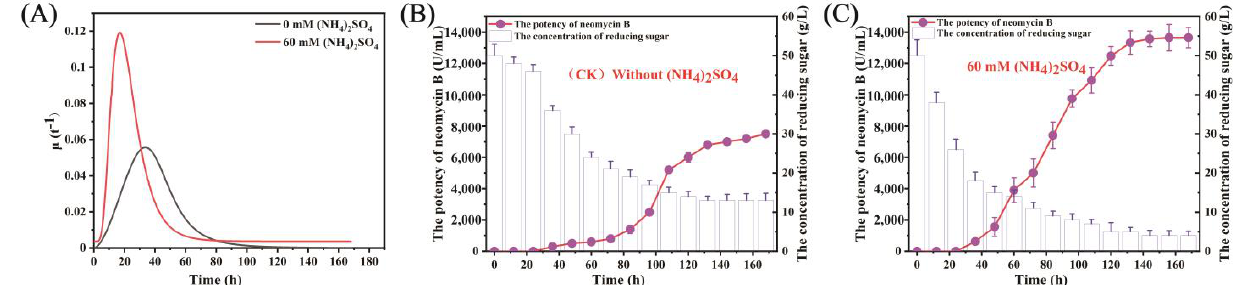
Figure 2. The effects of ammonium sulfate on the growth, reducing sugar utilization, and neomycin B biosynthesis in S. fradiae SF-2: ( A ) The effects of the addition of 60 mM (NH 4 ) 2 SO 4 on the specific growth rate. ( B , C ) The impact of the addition of 60 mM (NH 4 ) 2 SO 4 on reducing sugar utilization and neomycin B potency.